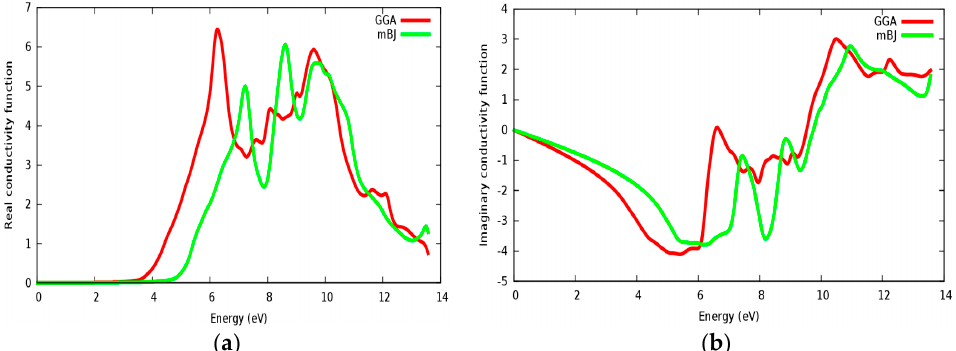
Figure 15. Conductivity function for SrZrO 3 : ( a ) Real part; ( b ) Imaginary part using both PBE-GGA and mBJ-GGA methods.